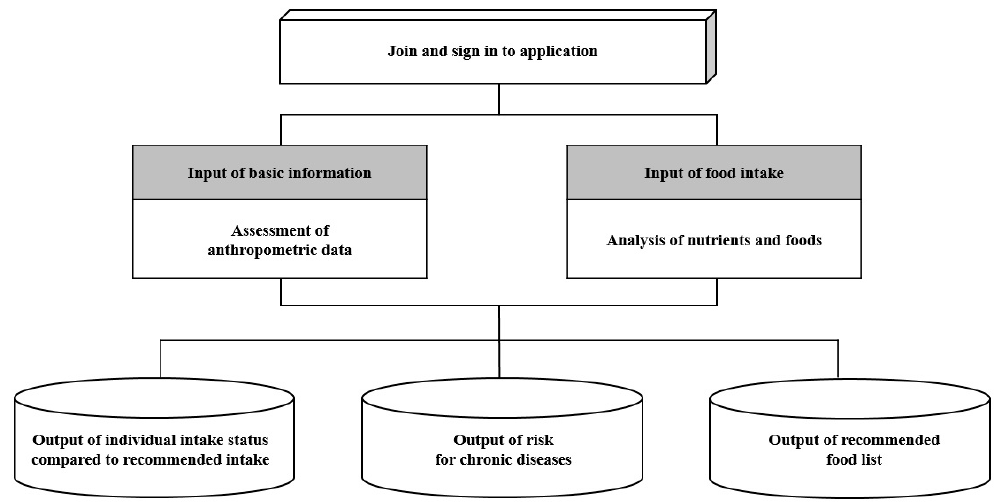
Figure 1. Flow chart of developing stage of application.